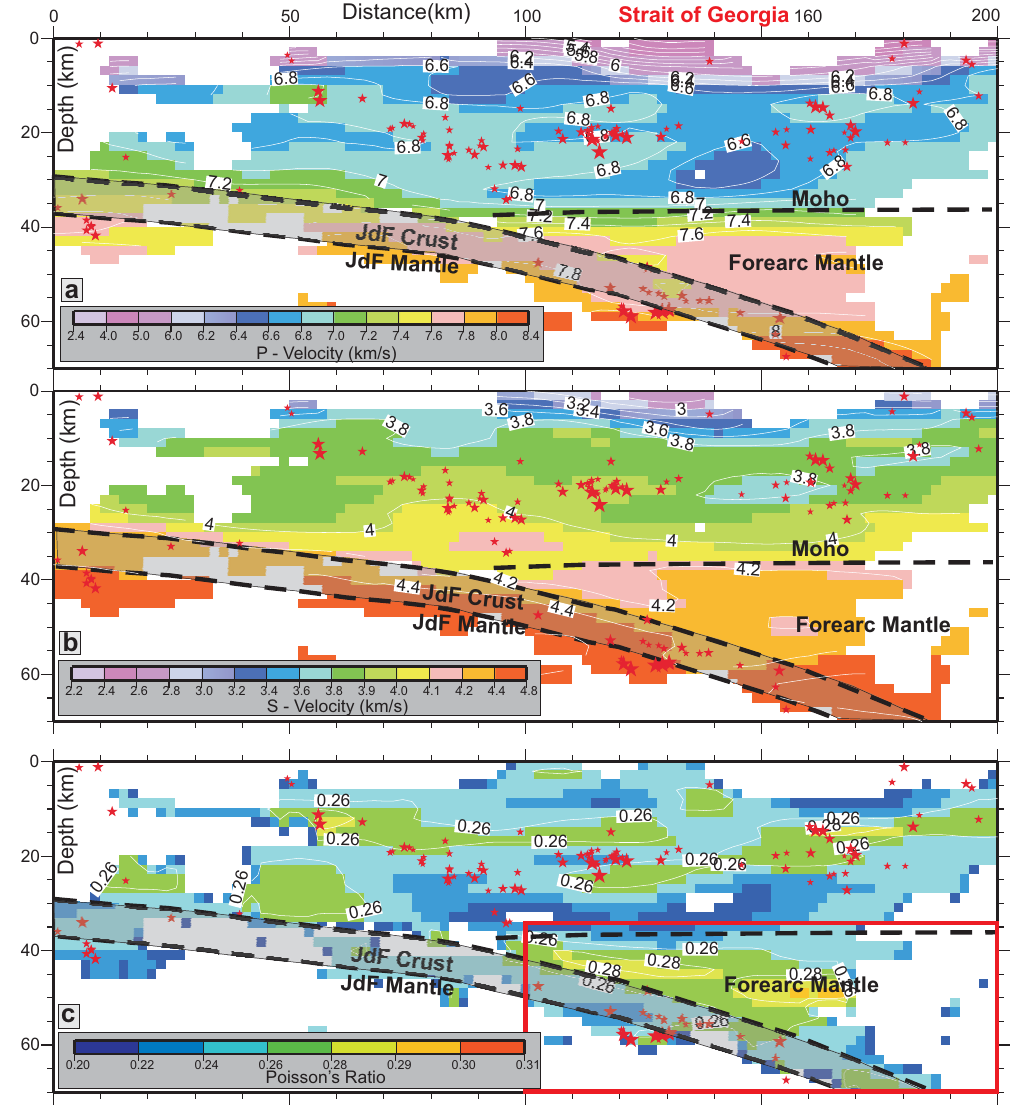
Fig. 4. Vertical cross-section along profile AB showing (a) P-wave velocity, (b) S-wave velocity, and (c) Poisson’s ratio. Earthquake hypocenters within 10km of the profile are plotted on the cross-sections as red stars. The red box in Fig. 4c shows the region for which volume percent serpentinization is shown in Fig.